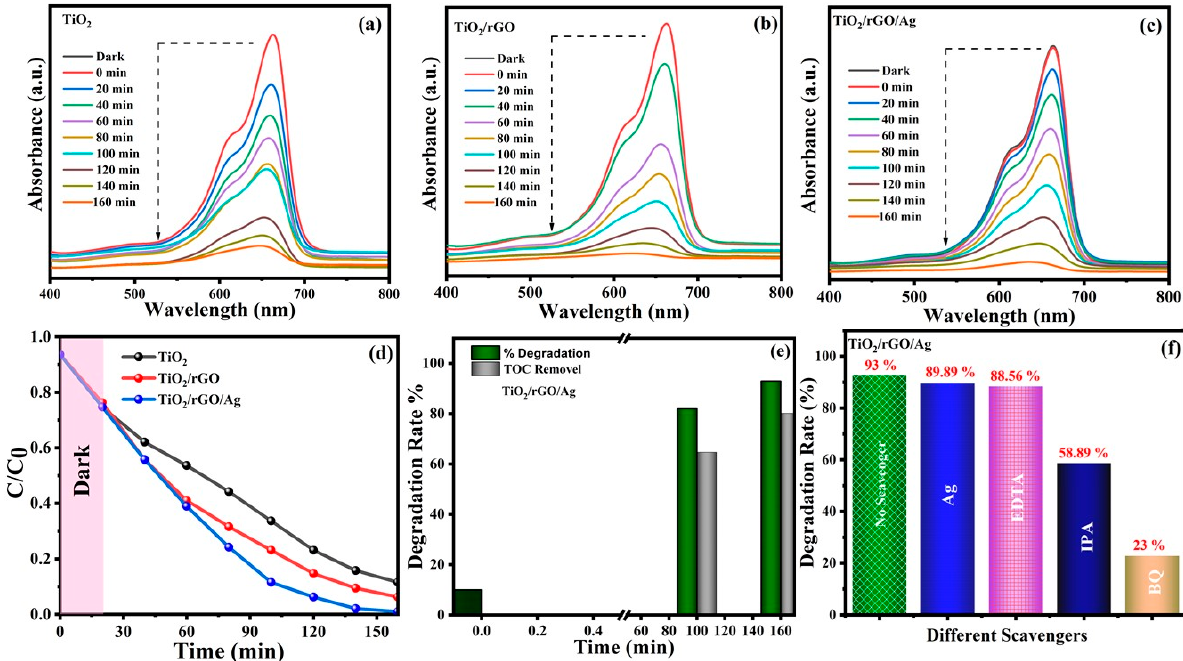
Figure 5. ( a – c ) UV absorption spectra of MB degradation with different interval time under natural sunlight, ( d ) plots of C/C 0 as a function of time (min) towards the photo degradation of MB, ( e ) TOC analysis was observed for TiO 2 /rGO/Ag at different intervals and the ( f ) photocatalytic degradation